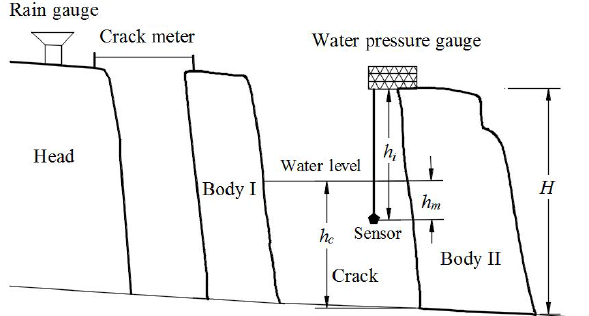
Figure 5. The installation schematic of water pressure gauge, rain gauge, and crack